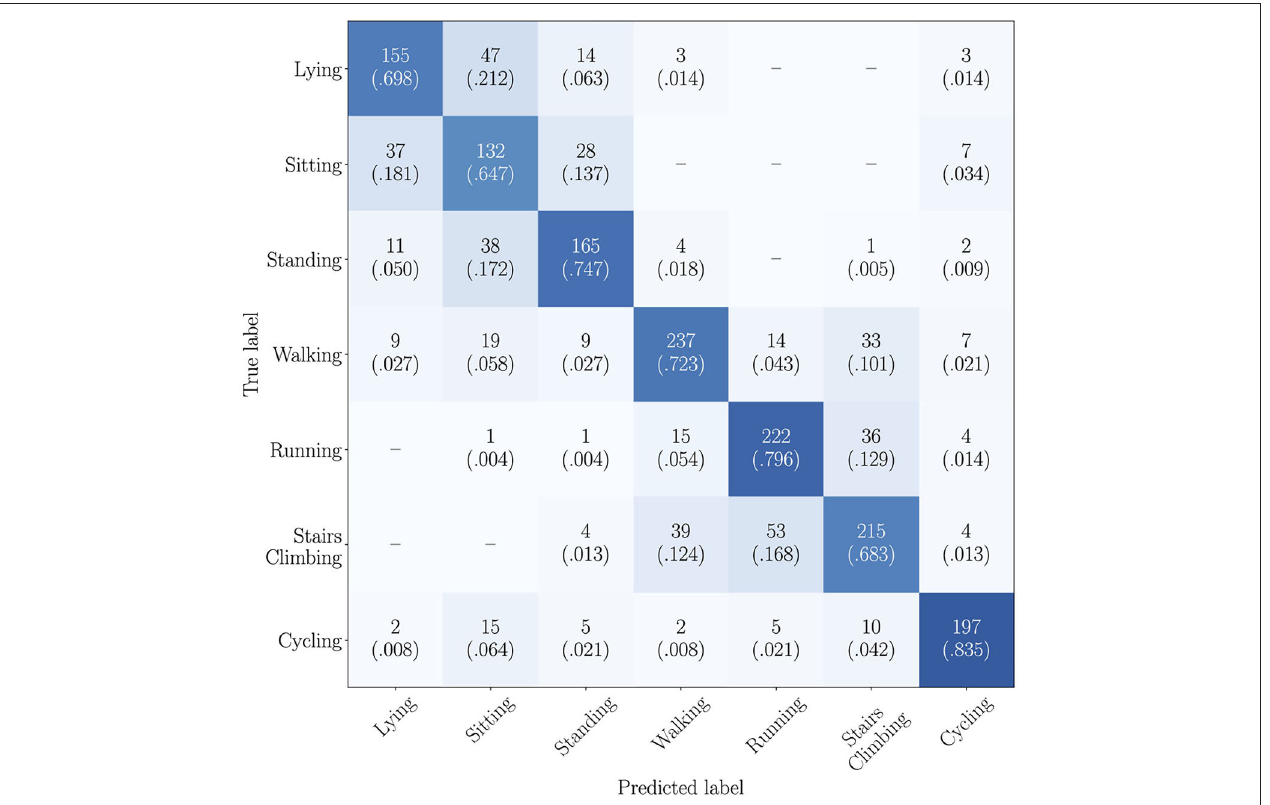
FIGURE 4 | Confusion matrix computed from the predictions inferred using the CNN-based approach exploiting f steps ⊗ hr ⊗ xyz as input features. Each cell contains the absolute and the relative number of samples of the actual class (row) classified into each possible activity of the recognition set (column). The relative information is also depicted using a color-scale: dark colors illustrate high percentages, while light colors, low percentages. Empty cells indicate no samples from the actual activity are classified into the corresponding